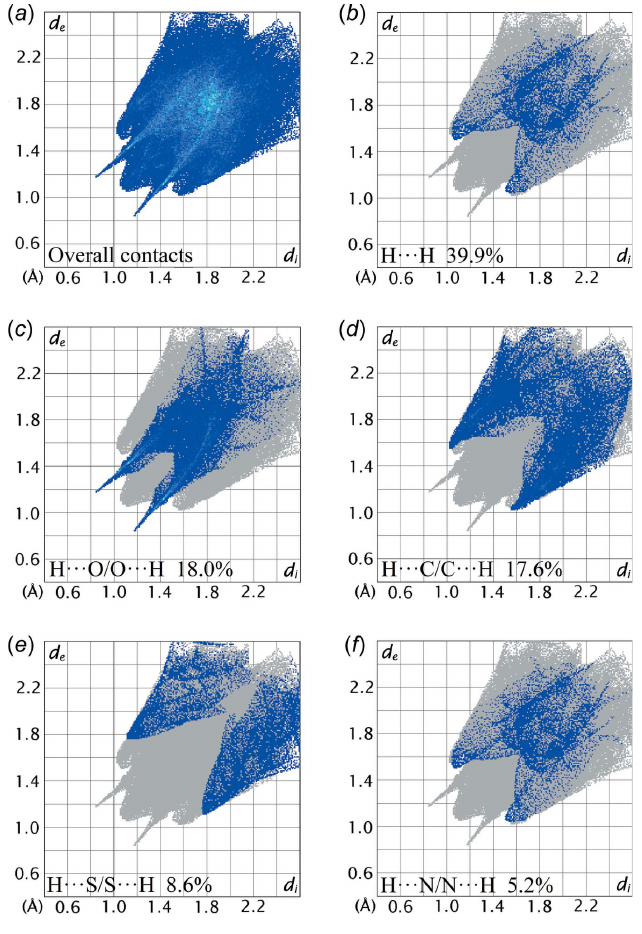
Figure 7 View of the Hirshfeld surface mapped over d norm for (I), highlighting C (cid:3)(cid:3)(cid:3) S short contacts. these shown as red spots on the d surfaces in Figs. 4 and 5.